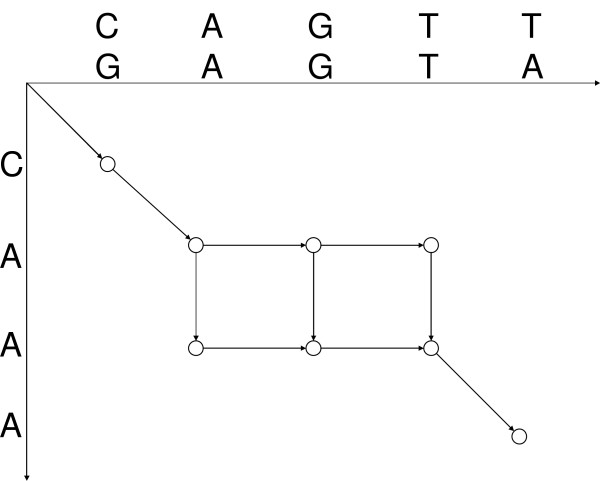
Dynamic programming table traversal. The multiple alignment prefixes (represented by o symbols) traversed by the one-state recursion, when the input is the homology structure of Fig. 1. (For clarity, the vectors are plotted in two dimensions instead of the actual three.) The homology structure is represented by the graph, and each directed path on this graph uniquely corresponds to an alignment that is compatible with the homology structure.